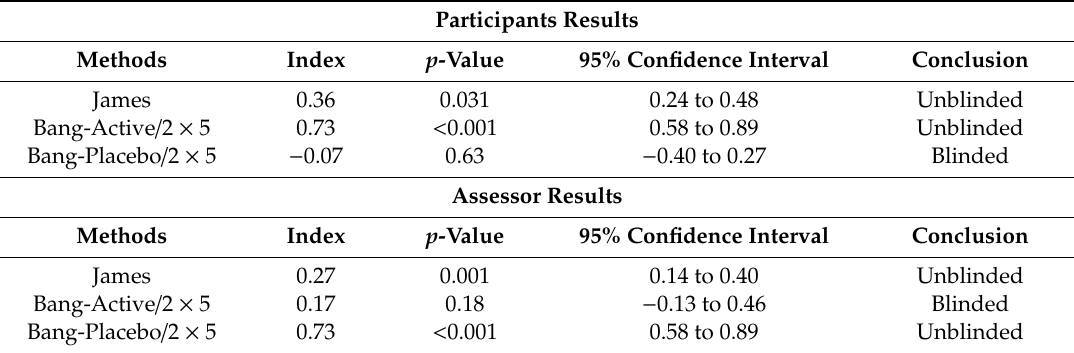
Table 5. Statistical analysis of blinding